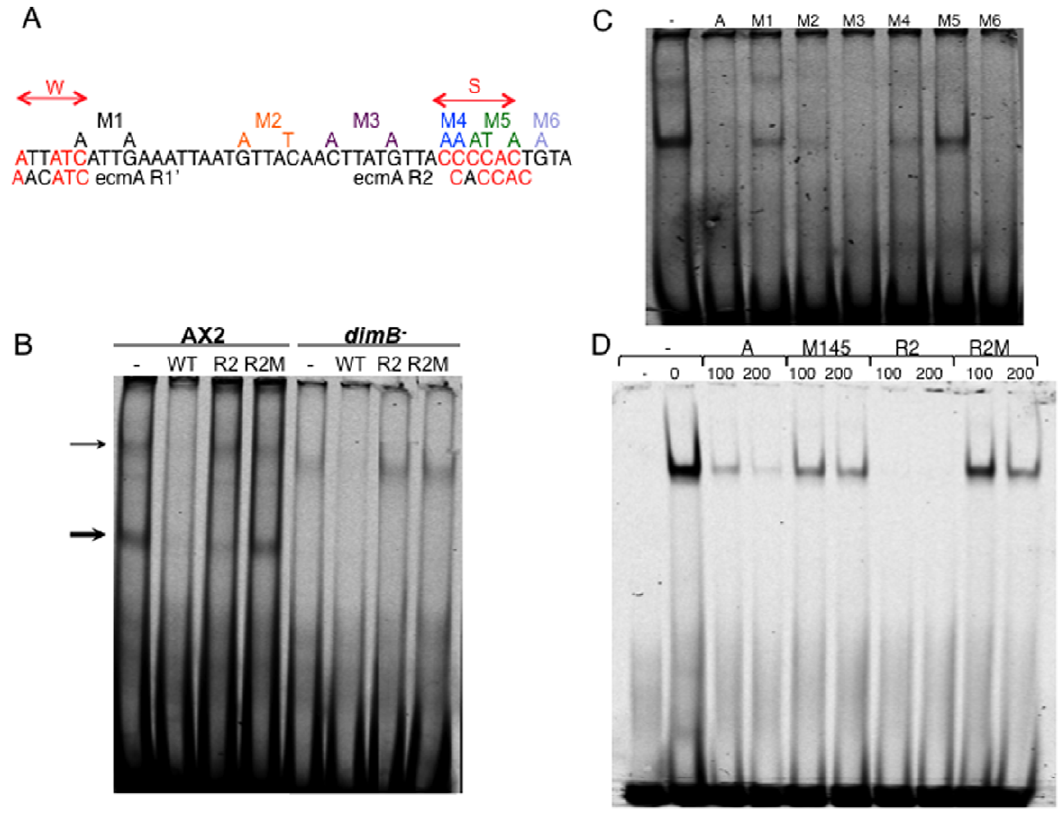
Figure 2. Mapping DimB binding sites in region A by gel retardation analysis. A) Alignment of regions S and W, the proposed DimB binding sites in region A of the pspA promoter, with the known DimB binding sites within the ecmA promoter: R2 and R1. Also indicated, above the sequence, are the positions of the point mutations used in scanning analysis of DimB binding. B) Total nuclear extracts obtained from Ax-2 and dimB- slug cells used in gel retardation with a region A probe. The competitors are the R2 and R2M sequences from within the ecmA promoter [8] C) Total nuclear extracts obtained from Ax-2 slug cells used in gel retardation with a region A probe. The competitors are region A itself and scanning mutants M1 to M6. D) Gel retardation with recombinant DimB using an A region probe. Competitors are: A itself, and oligonucleotide M145, containing region A with mutations M1, M4 and M5 that collectively mutate the S and W DimB binding sites. Again, the control competitors are the R2 and R2M sequences from within the ecmA